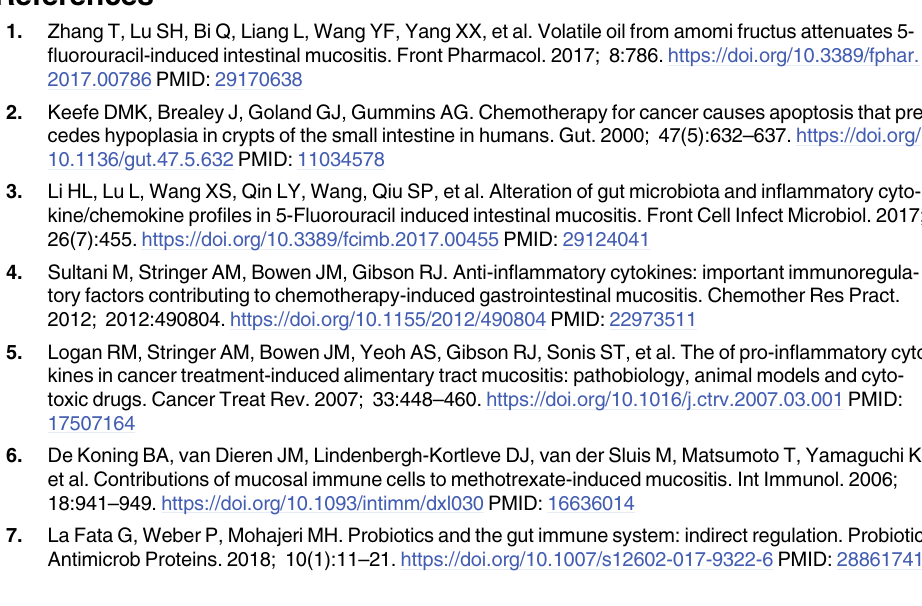
S1 Table. The effect of 5-FU on S . thermophilus ST4 cytotoxicity.